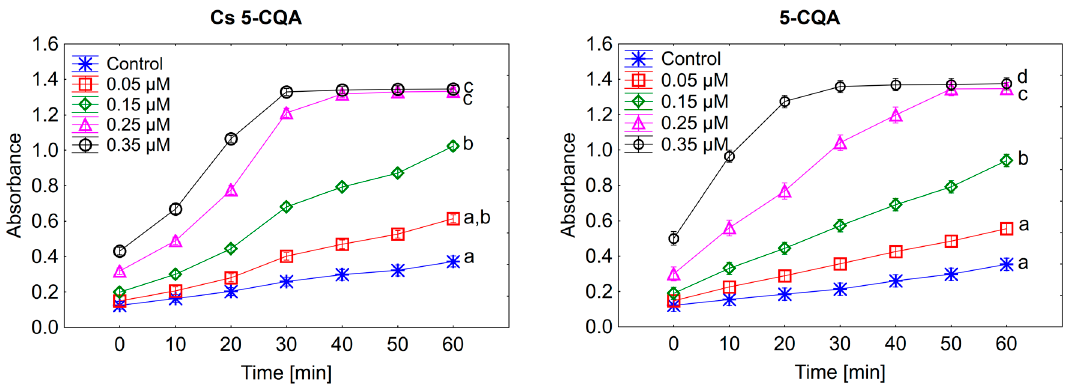
Figure 3. The effect of different concentrations (0.05–0.35 μ M) of chlorogenic acid and its alkali metal salts on the oxidation of trolox.